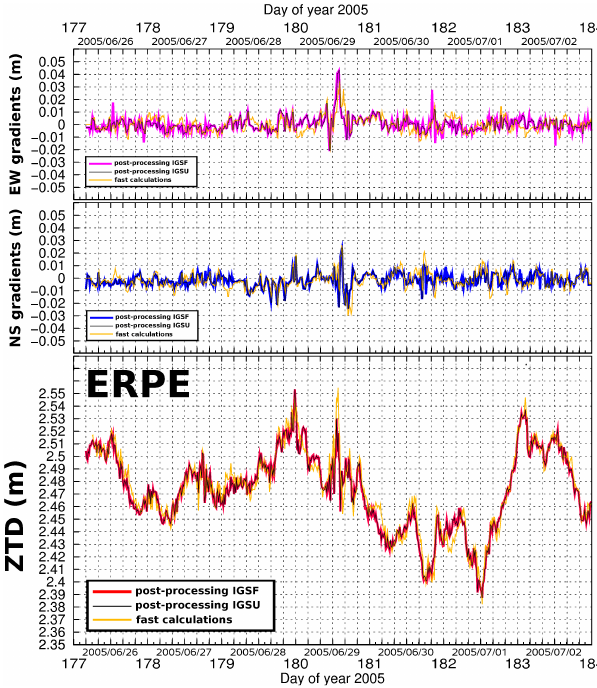
Figure 16. Time series of ZTD and gradients (from 26 June to 3 July 2005) from post-processed (final orbits IGSF and ultra-rapid orbits IGSU) and from fast